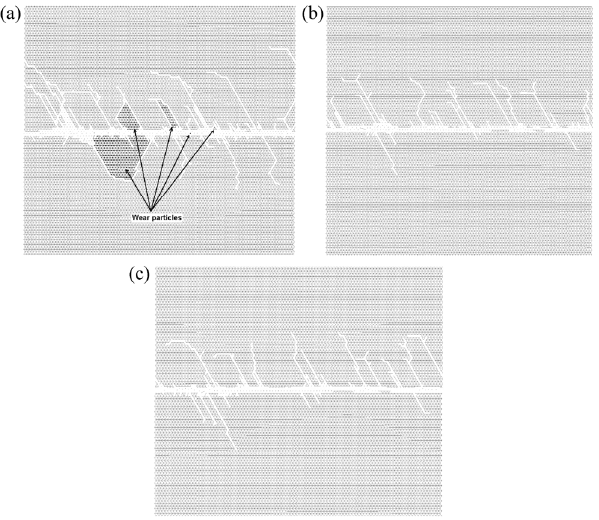
Fig. 14 Subsurface fracture in Y-TZP at dilatancy coefficient